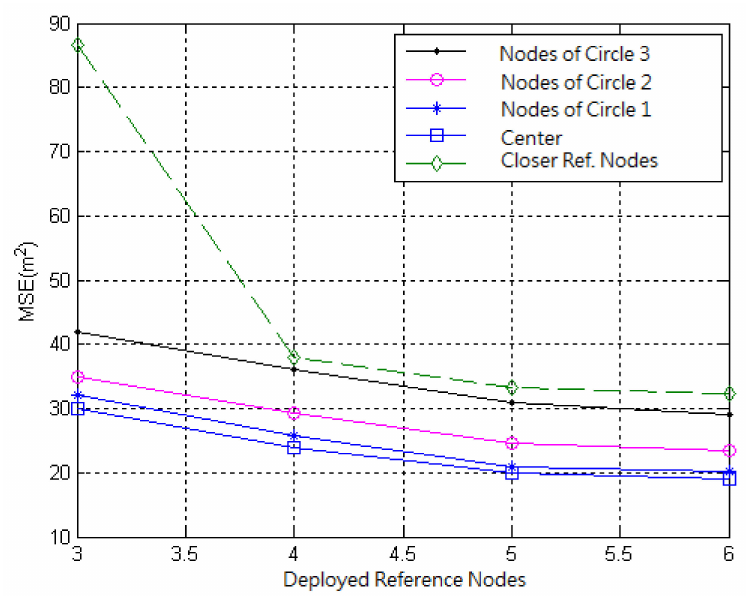
Figure 15. Comparison between center point and directly selected reference node.